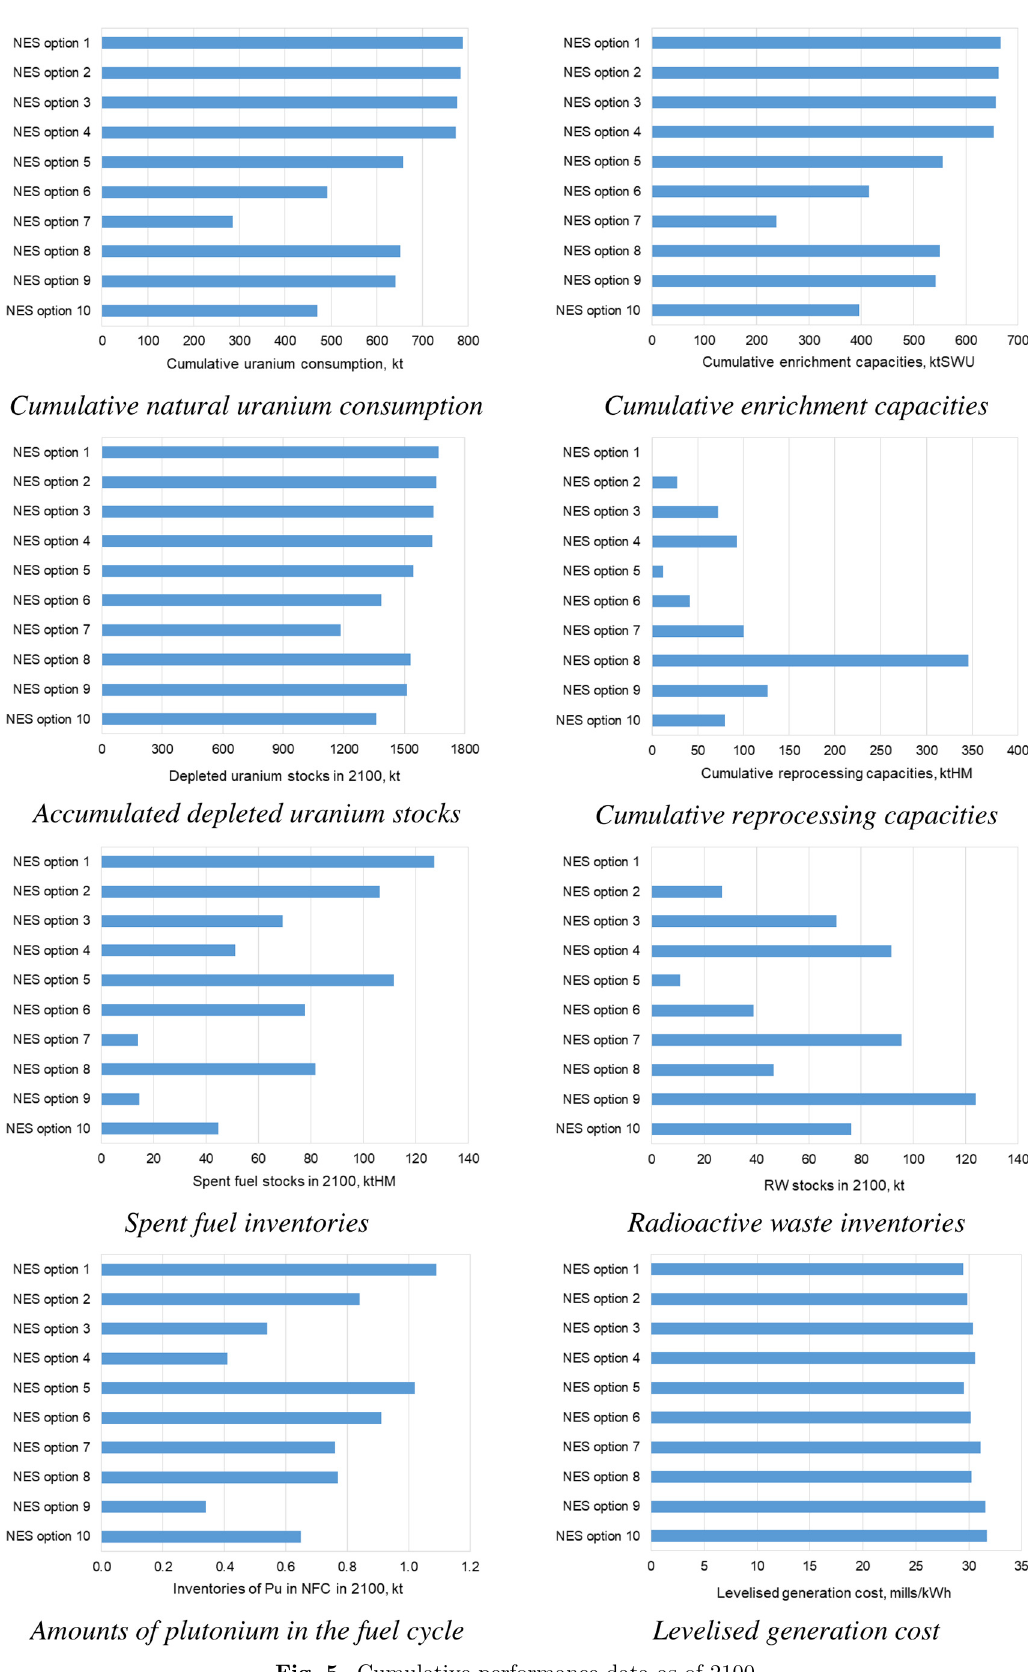
Fig. 5. Cumulative performance data as of